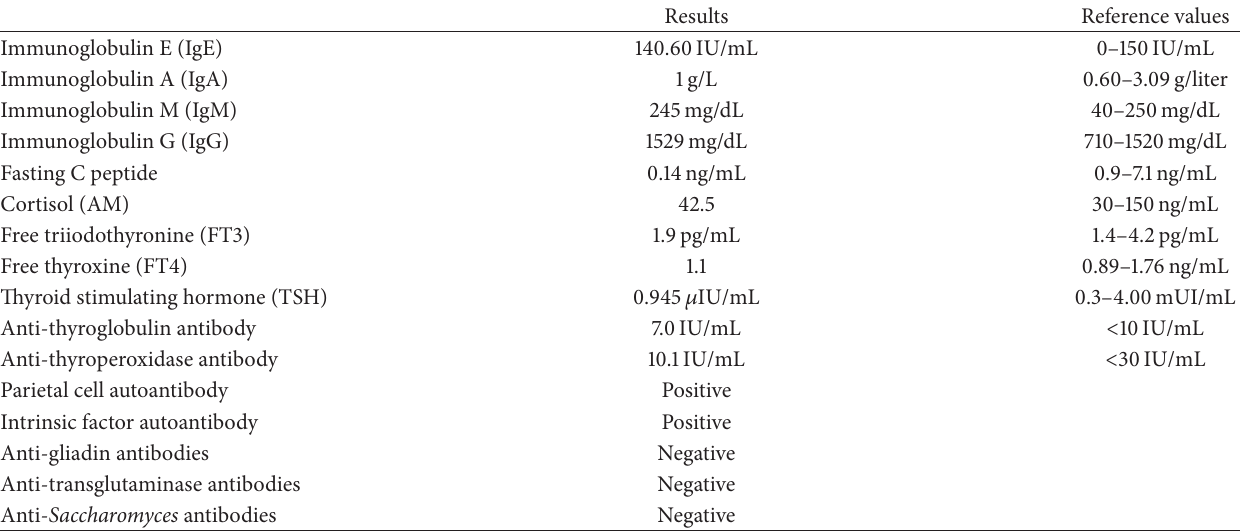
Table 3: Complementary laboratory workup.